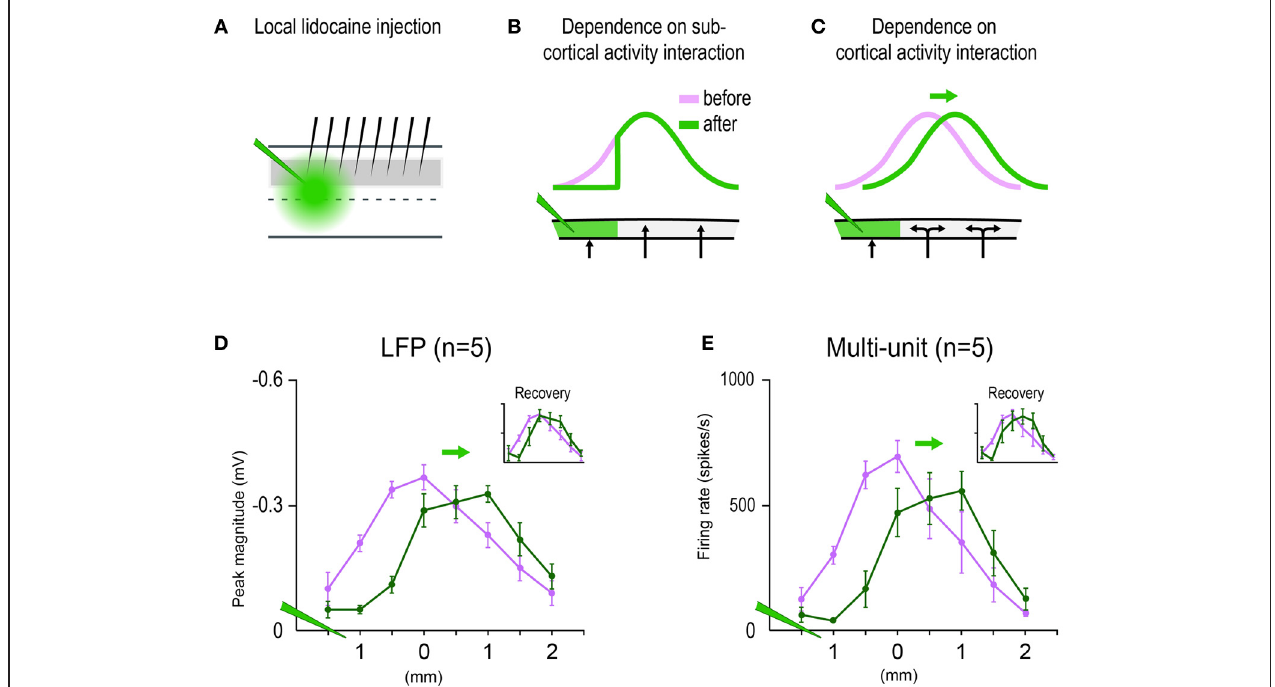
FIGURE 5 | Multi-whisker functional representation (MWFR) for the 24-whiskers array dependent on single whisker functional representation (SWFR) interactions occurring at the cortical level. (A) Eight electrodes spaced 0.5mm apart recorded the MWFR for 24-whiskers (middle electrodes aimed at MWFR peak activity location) before and after local lidocaine injection (green) deposited distal (1.5mm) to the middle electrodes. 1 µ L of lidocaine (10%; Sigma) was slowly microinjected over the course of 3min at 300–450 µ m cortical depth. (B) If sub-cortical activity interactions are the sole contributors to the MWFR, then only local silencing of cortical activity within the lidocaine site would occur which, in turn, would lead to a decrease in MWFR response magnitude only within the lidocaine site and thus no shift in MWFR peak activity location nor increases in MWFR response magnitude would occur outside the lidocaine site. (C) If SWFR interactions indeed occur at the